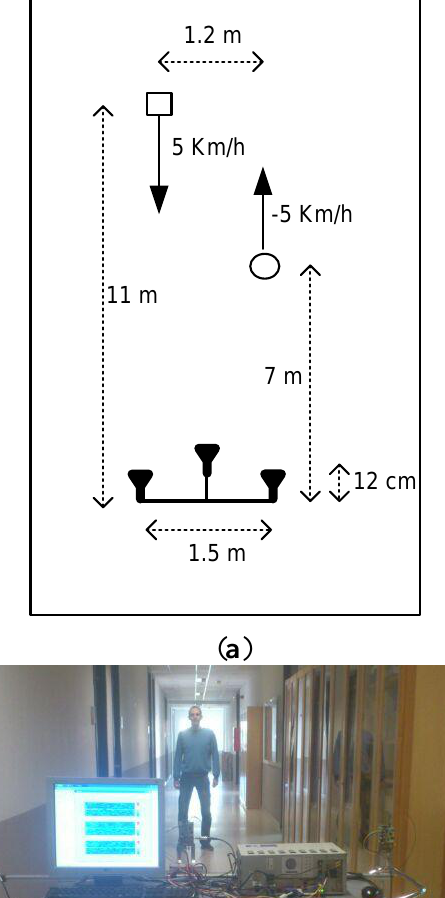
Figure 11. Experimental scenario ( a ) Top-view scheme ( b ) Photograph of the